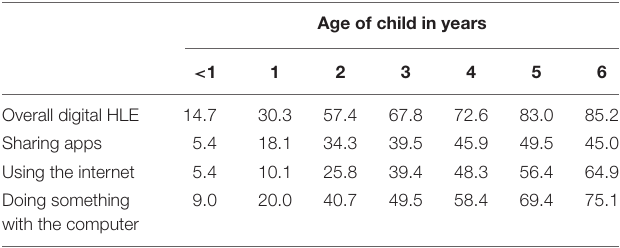
TABLE 5 | Proportion of shared digital media activities in the home (at least seldom).